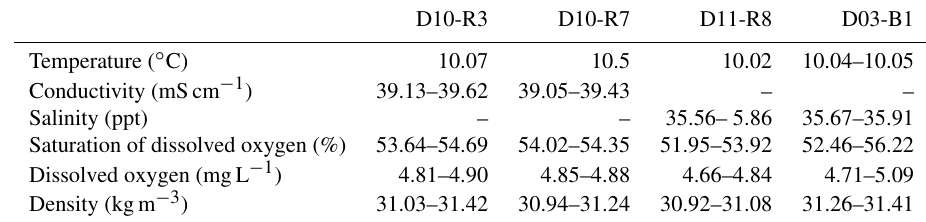
Figure 4. ROV still frames from the Al Gacel MV (Dives 10 and 11). (a) The eastern side of the volcano, displaying a field of sponges, corals and carbonates. (b–c) Active pockmark sites on the east side of the volcano, displaying authigenic carbonate surrounded by shells of chemosynthetic bivalves, fragments of scleractinian and octocorals, and sulfide-oxidizing bacterial mats. (d) Meter-sized carbonate blocks located on a slope at the summit of the volcano. Table 2. In situ water variables measured during sampling with ROV